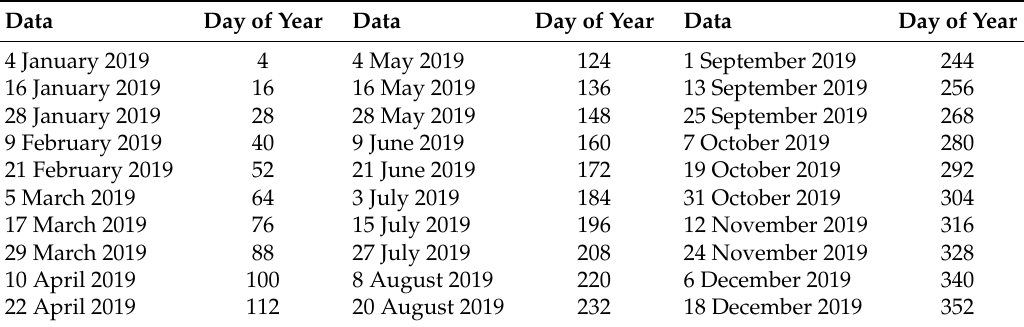
Table 1. The Sentinel-1A dataset used in this study.